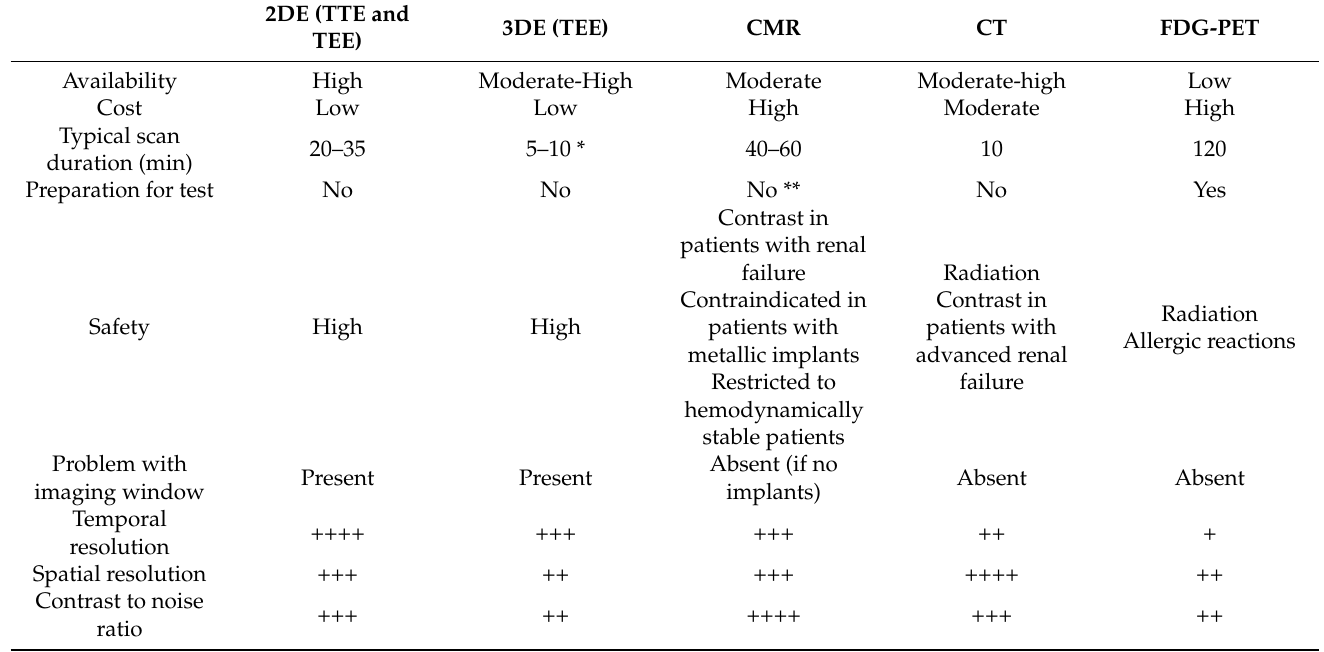
Table 1. The strengths and limitation in assessment of aortic stenosis and left ventricular structure and function using different imaging